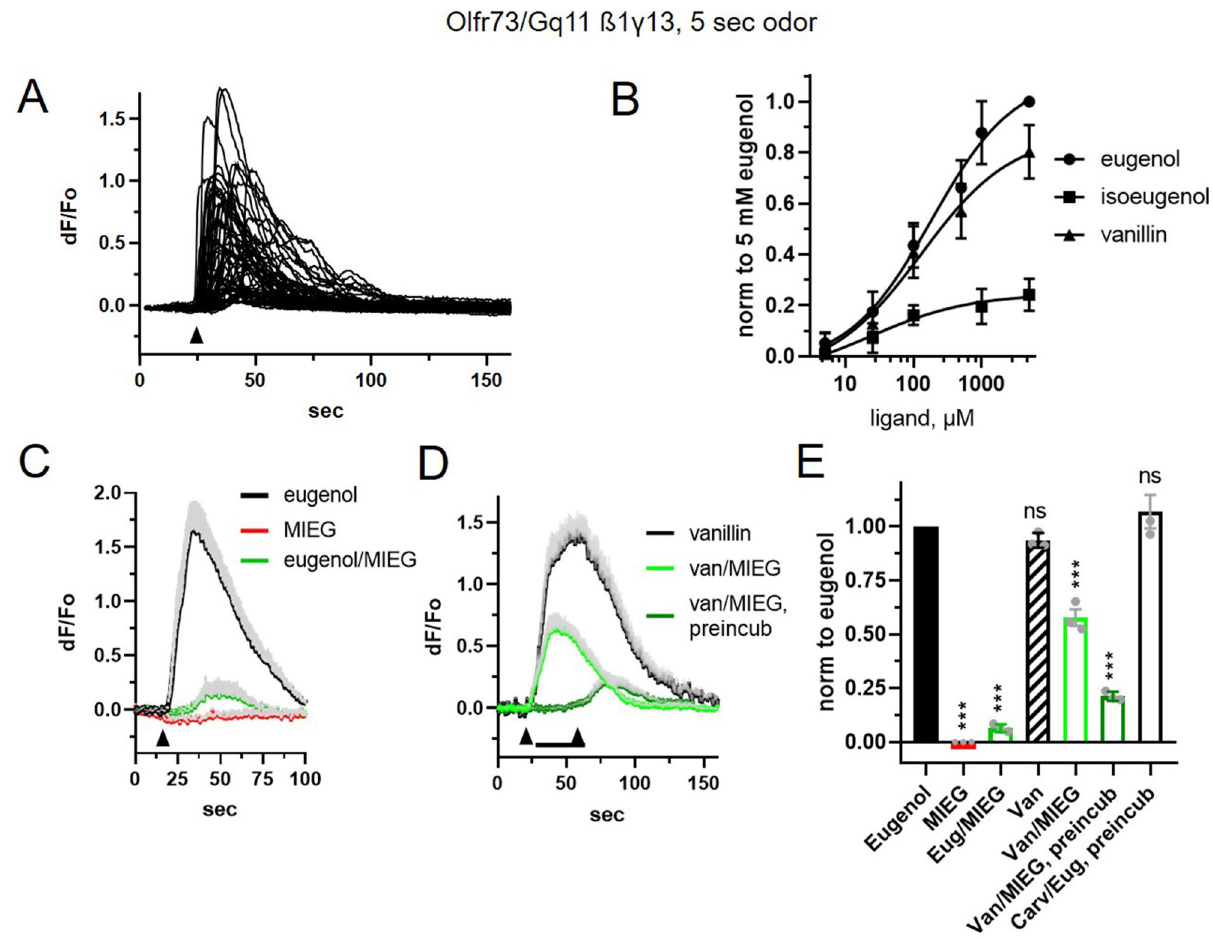
Figure 5. Co-expression of Olfr73 with a native heteromeric G-protein Gq11/b1/g13 does not change the antagonism in the binary mix of agonists and putative antagonists. ( A ) Co-expression of Olfr73 with a complete heterotrimeric G-protein Gq11 couples the OR to the endogenous PLC-dependent calcium release pathway and evokes transient increase of cytoplasmic Ca 2+ following a 5-s application of eugenol (100 µM) indicated by arrow below the traces. The eugenol-evoked change of intracellular Ca 2+ was measured individually in 25 cells. ( B ) Concentration-dependence of the response elicited by three Olfr73 agonists. The response represents changes of intracellular Ca 2+ normalized to that evoked by 5 mM eugenol. Data points were fitted to the sigmoidal curve yielding the following EC 50 values (184 ± 62 µM, eugenol, circles; 23 ± 8 µM, isoeugenol, squares; 130 ± 73 µM, vanillin, triangles). Data were collected from 25–30 cells in 3 independent experiments. ( C ) Binary mix of eugenol (100 µM) and MIEG (1 mM) as well as ligands alone were applied at indicated time (arrowhead). ( D ) Another potent agonist, vanillin (100 µM) was antagonized by methylisoeugenol (MIEG, 1 mM) but required pre-incubation for 30-s to achieve near complete inhibition. Traces represent mean ± SEM measured in 20–30 cells. ( E ) Responses in all groups were normalized to the control response evoked by eugenol alone. Carvone (1 mM, Carv) was used as a negative control acting as a non-agonist and imposing no antagonism in the mix with eugenol. Data represent three independent experiments. Wilcoxon paired t-test was applied, *p = 0.017; **p = 0.0014; ***p = 0.0001. Data are shown as mean ± antagonistic or inhibitory interaction of eugenol and its putative antagonists in native mouse OSNs ectopically expressing untagged Olfr73. In vitro-expressed Olfr73 mediates antagonism between ligands independently of the down- stream signaling pathway. Since previous research suggested that antagonism in binary mixtures of ligands may depend on the signaling pathway downstream of the OR in question 9 , we explored the effect of sub- stituting different G proteins in our in vitro assay. First, we confirmed that mammalian ORs can robustly couple to endogenous stimulatory signaling pathways, mediated not only by Gs/olf but also by Gq11, found in ciliary proteome in mammalian OSNs 34 . Eugenol (100 µM) consistently activated calcium release in HEK293 cells co- expressing Olfr73 with the complete heterotrimeric G-protein, Gαq11/ß1/γ13 (Fig. 5A). Using this expression system, we then measured the concentration-dependence of the response to eugenol, vanillin and isoeugenol (Fig. 5B). Co-expression of another mouse OR, Olfr599 with the heterotrimeric G-protein, Gαq11/ß1/γ13, also